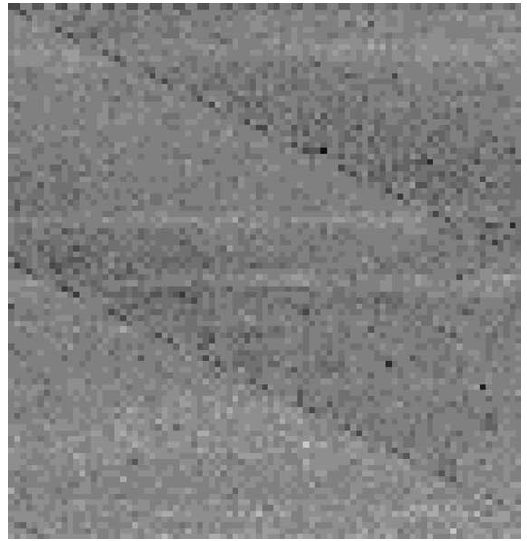
Fig. 2. Spatial plot of M values after lowess normalization ( M vs A plot for this data is shown in Fig. 3). Note the presence of spa- tial patterns. Data courtesy Prof. A.B. Smit, Department of Molec- ular and Cellular Neurobiology, Vrije Universiteit, Amsterdam, The